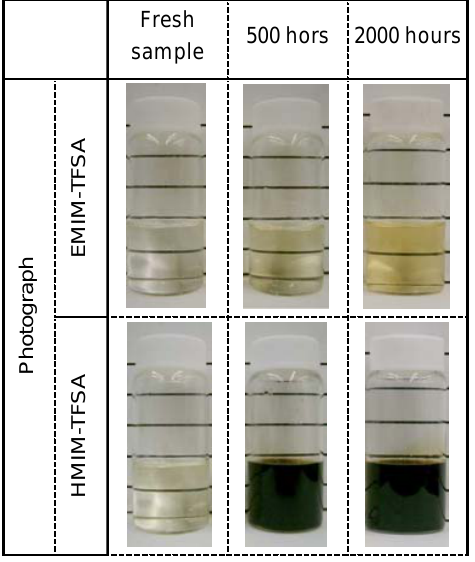
Figure 10. Photographs of samples kept at 150 °C.